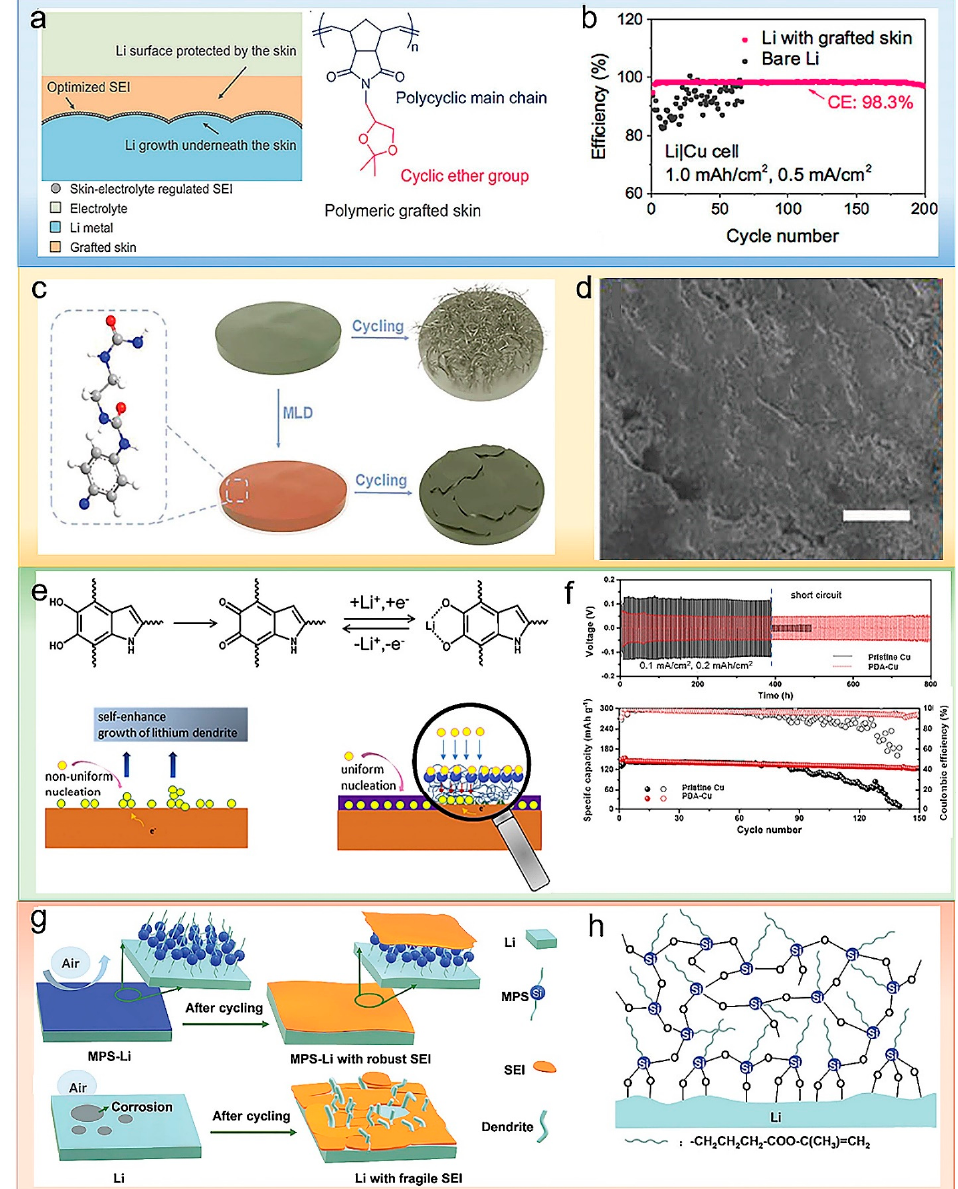
Figure 3. ( a ) (Left) Illustration of the different interfacial chemistries of Li metal with grafted skin in a carbonate electrolyte. (Right) Chemical structure of the polymer skin, composed of a cyclic ether group (pink) and a polycyclic main chain (blue). ( b ) CEs of Li deposition/dissolution on a Cu electrode. Reproduced with permission [39]. Copyright 2017, American Chemical Society ( c ) Schematic diagrams showing the effect of MLD coating on a Li anode when cycling. ( d ) Surface morphologies for bare Li and Li@P10 after 20 cycles of stripping/plating. The lengths of scale bars are 20 µ m for images [40]. Reproduced with permission. Copyright 2019, John Wiley and Sons. ( e ) Diagram of the mechanism of PDA induced Li deposition. ( f ) Voltage–time profiles of the Li plating/stripping process with a cycling capacity of 0.2 mAh cm − 2 at 0.1 mA cm − 2 in symmetric Li@Cu/Li@Cu cells with pristine Cu and PDA-Cu current collectors (top). Long-term Reproduced with permission. Copyright 2019, Elsevier. ( g ) The dense MPS layer isolates the lithium from the air, and the MPS layer protects the lithium metal (top). Schematic diagram of the exposure of raw Li to air (bottom). ( h ) Schematic illustration of the structure of MPS-Li [46]. Reproduced with permission. Copyright 2021, John Wiley and